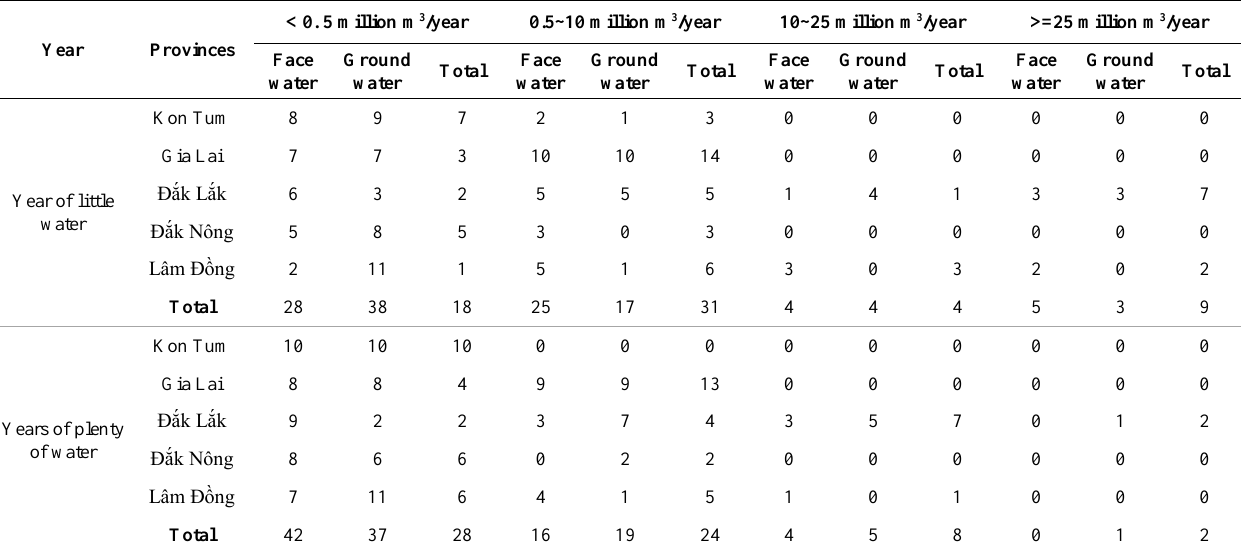
Table 1. Statistics on the number of districts facing water shortage [16]